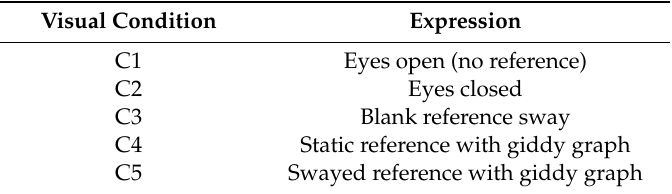
Table 1. Visual conditions in the experiment